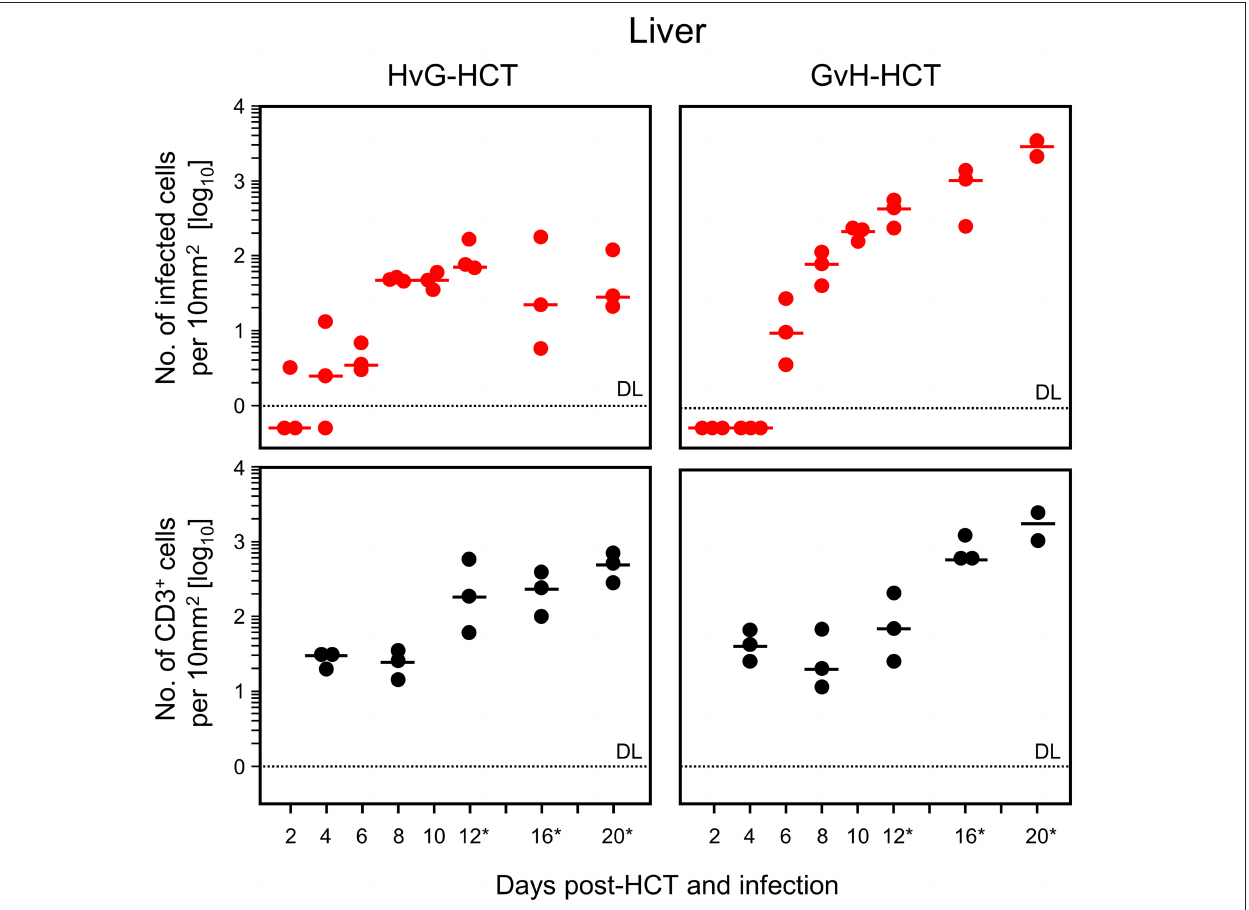
FIGURE 4 | Differential kinetics of virus spread and liver tissue infiltration by T cells after HvG-HCT compared to GvH-HCT. Infected liver cells, which are mostly hepatocytes but also endothelial cells and liver macrophages (Kupffer cells), were identified and quantitated in liver tissue sections by IHC specific for the intranuclear viral IE1 protein (upper panels). Liver-infiltrating T cells were identified and quantitated by IHC specific for the signaling molecule CD3 ε of the TCR-CD3 complex (lower panels). Data refer to representative 10-mm 2 tissue section areas. Symbols represent data for mice tested individually. Median values are marked. Observation times for which histological images are shown in Figure 5 are marked by an asterisk. DL, detection limit of the